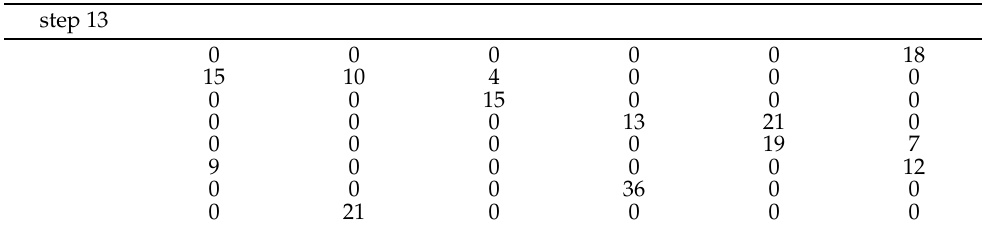
Table 7. Results of subsequent iterations and feasible solution for Vogel’s Approximation Method